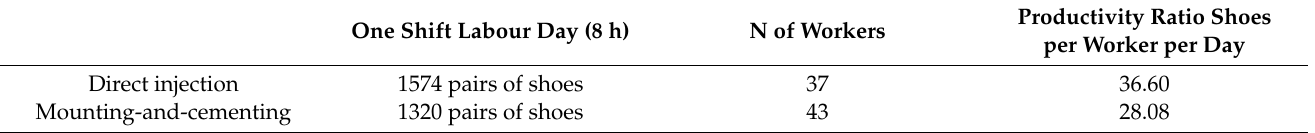
Table 5. Productivity compression of a factory with direct-injection vs. mounting-and-cementing systems. One Shift Labour Day (8 h) N of